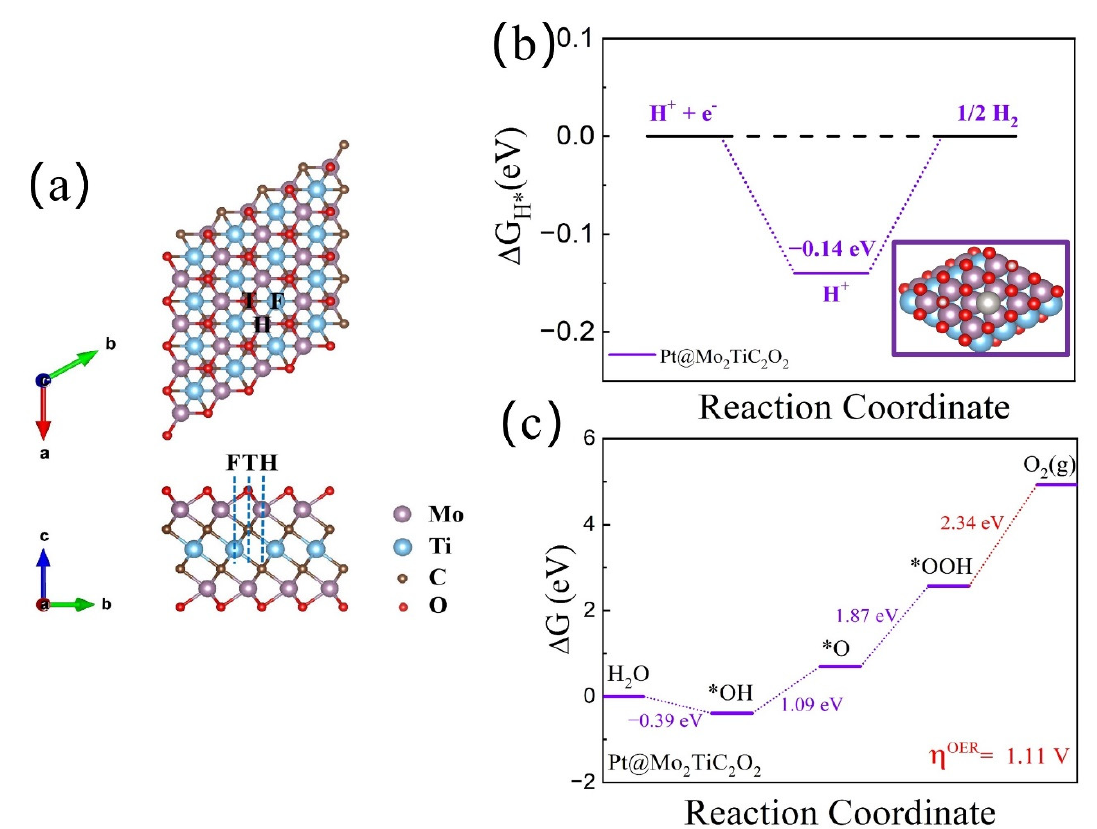
Figure 1. ( a ) Top view and front view of the Mo 2 TiC 2 O 2 and three different single-atom anchoring sites: fcc (F), top (T), and hcp (H). Calculated free energy profile of Pt@Mo 2 TiC 2 O 2 SACs for ( b ) HER and ( c ) OER; the red line represents the energy-consuming step. The “ ∗ ” symbol represents the adsorption site. a, b and c are the three directional axes of the cell structure, respectively.